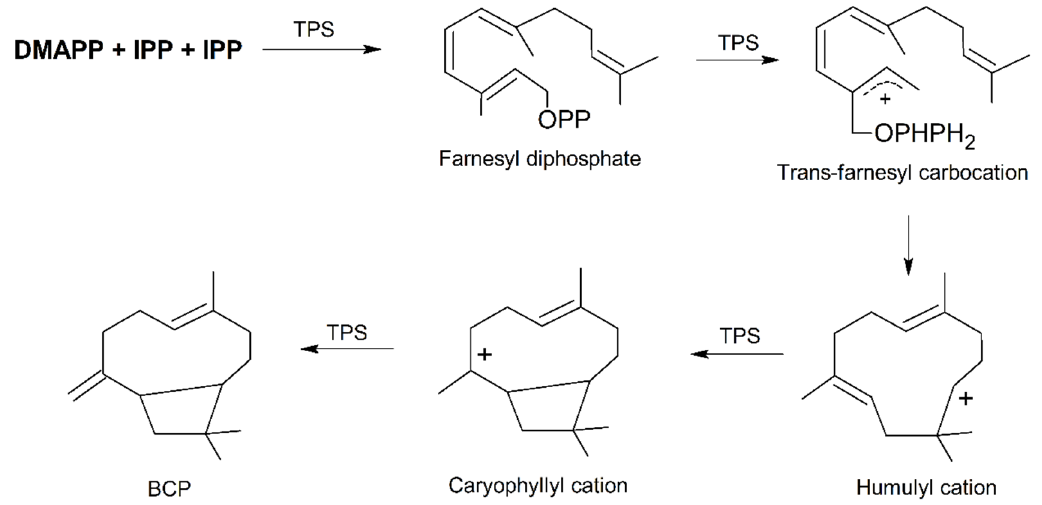
Figure 1. Simplified mechanism of the formation of ( E )- β -caryophyllene (BCP) from DMAPP and IPP. Abbreviations: DMAPP, dimethylallyl diphosphate; IPP, isopentenyl diphosphate; TPS, terpene